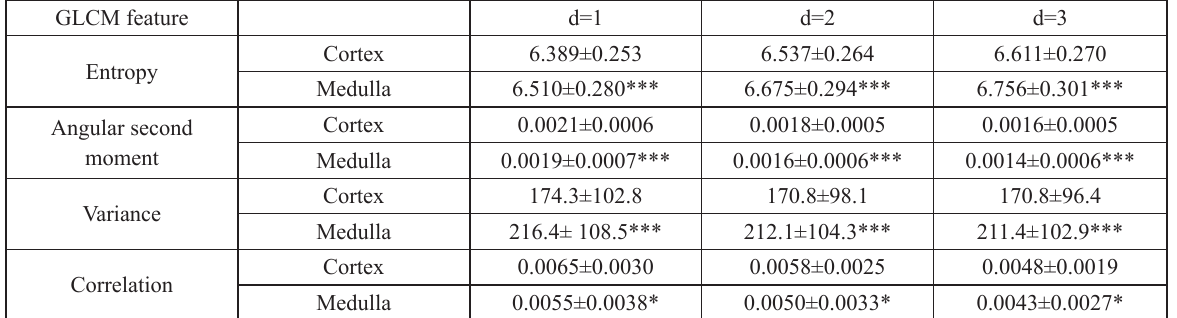
Average values of chromatin entropy, angular second moment, variance and correlation for different GLCM distances ( d